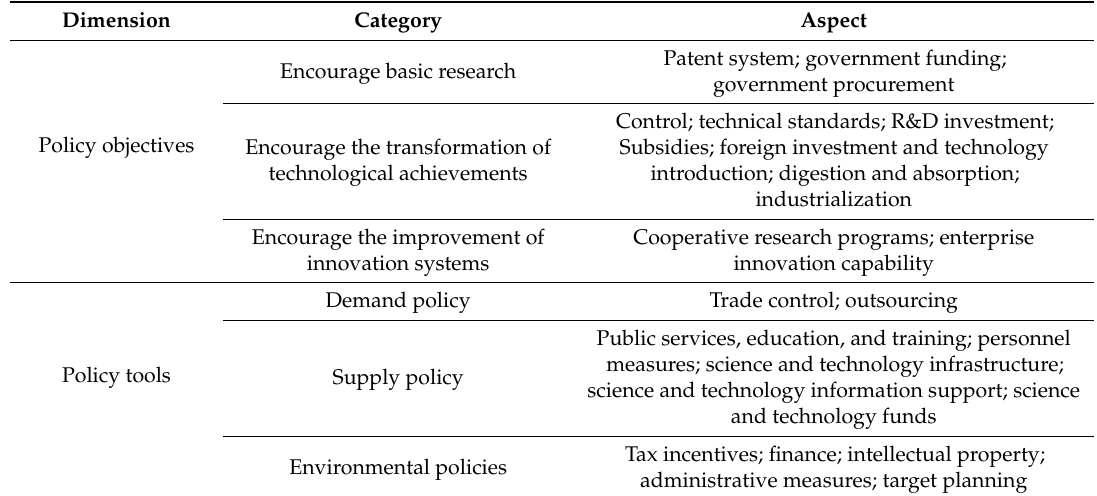
Table 1. Classification of fiscal and tax policies to stimulate